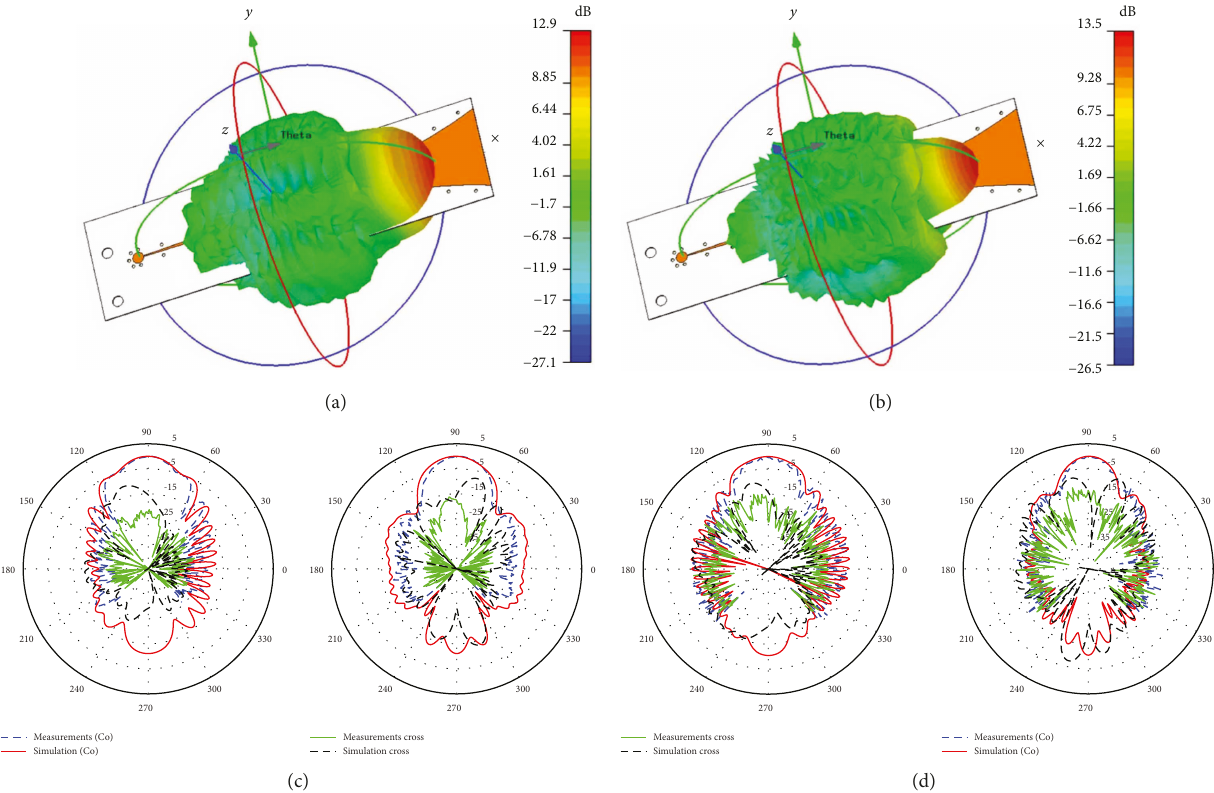
Figure 3: 3D radiation pattern of the proposed antenna at (a) 28GHz with a gain of 12.9 dBi and (b) 38GHz with a gain of 13.59dBi. Simulated and measured E-plane (left side) and H-plane (right side) 2D radiation patterns at (c) 28 GHz and (d) 38 GHz.